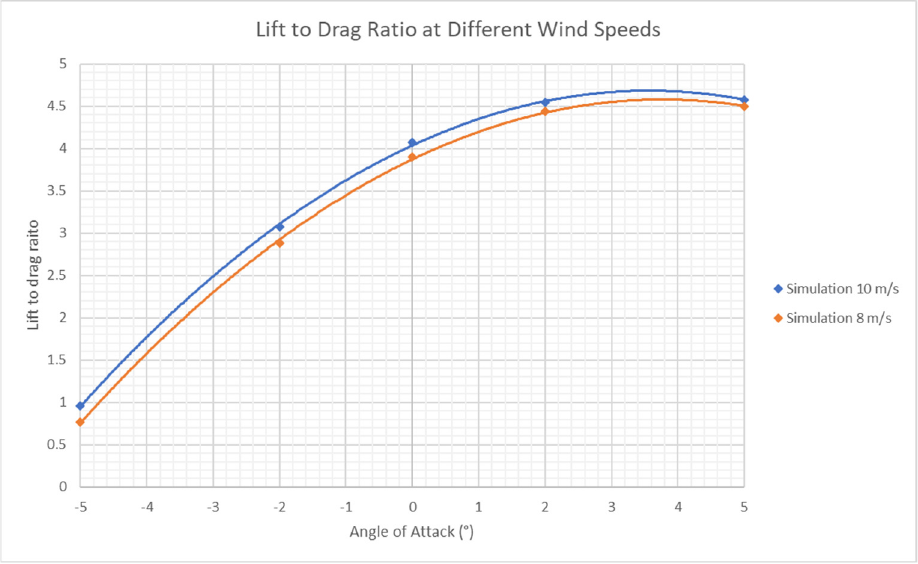
Figure 7. Single blade lift to drag ratio.